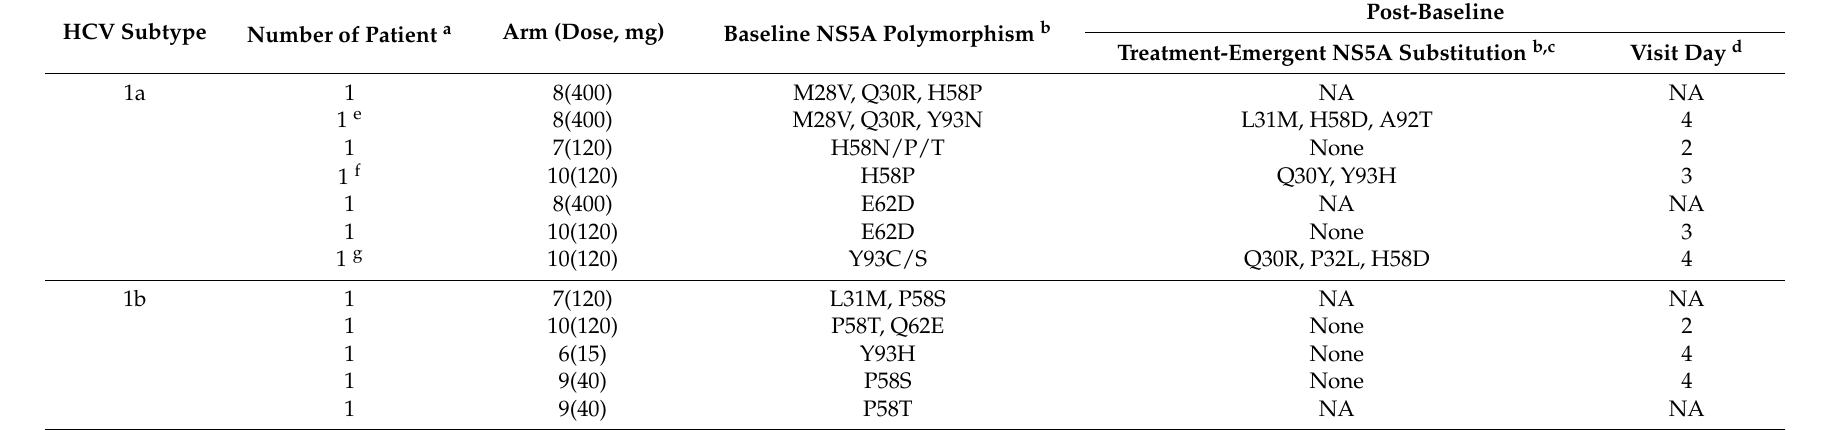
a Table does not list 28 patients without baseline polymorphisms; 11 of these 28 patients had post-baseline sequence data available, and none of the 11 patients had treatment-emergent substitutions. b For substitutions in a mixture with wild-type sequences, only the substitutions are shown. Substitutions at NS5A amino acid positions 24, 28, 29, 30, 31, 32, 58, 62, 92, and 93 were included in the analysis. c Substitutions detected in the latest sample with an HCV RNA level ≥ 1000 IU/mL during 3-day monotherapy. d Post-baseline samples collected prior to dosing of drug on the days of visit; e.g., a “visit day 3” sample represents a sample collected after 2 days of monotherapy. e Patient A. f Patient B. g Patient C. NA: Not available due to low viral titer (<1000 IU/mL) in samples collected at all post-baseline time points. None: No treatment-emergent substitutions